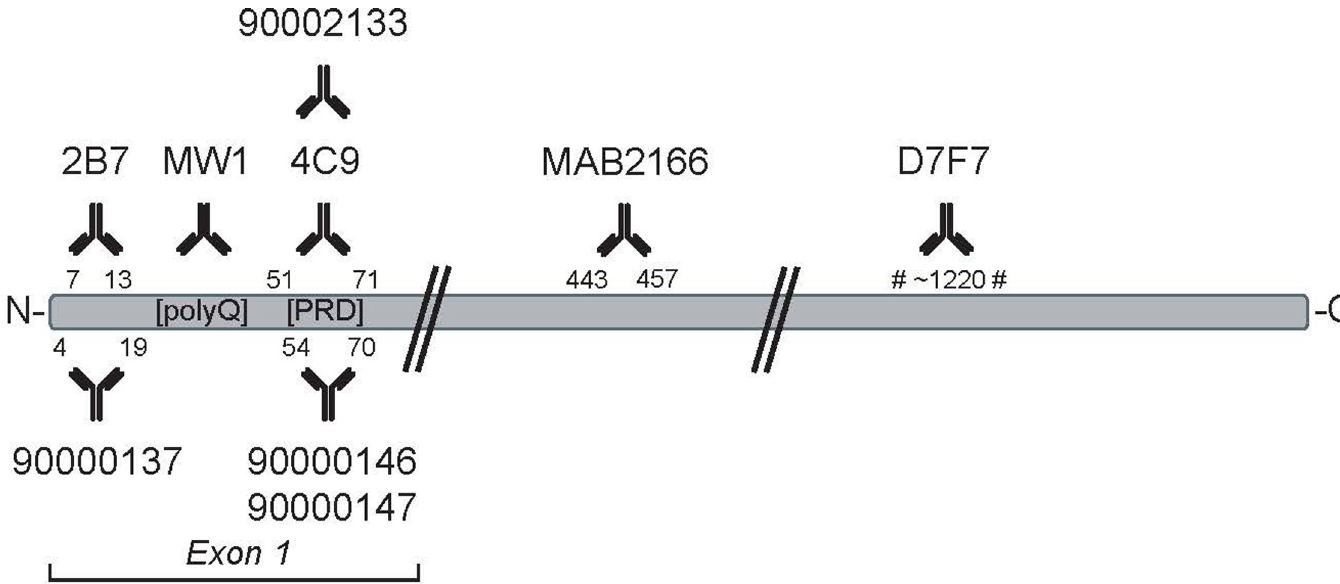
Fig 1. Schematic illustrating the epitopes of anti-HTT antibodies used for MSD assays. Monoclonal and polyclonal antibodies are shown at the top and the bottom, respectively. Antibodies 90000147 and 90002133 are mouse-selective; antibodies 90000146 and 4C9 (when used as a detection antibody) are human-selective, all other antibodies are not